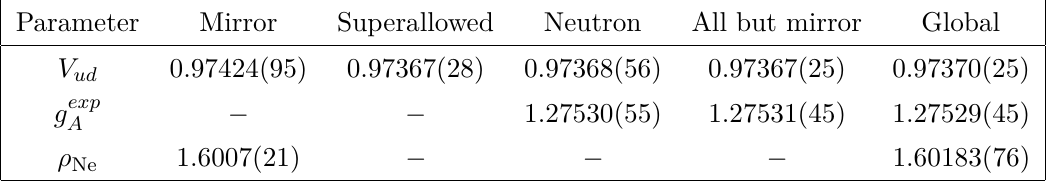
Table 3 . Values for the CKM element V ud , the axial charge of the nucleon g exp ratio of 19 Ne, obtained from fits assuming the SM as the fundamental theory. The columns indicate the different subsets of data used in the fits. The errors of g exp the nominal errors (i.e. not inflated a posteriori), so that they reflect the weight that the neutron dataset has in the global fit, where no S factor is needed since χ 2 figure 1. Let us note for completeness that pion semileptonic decay gives V